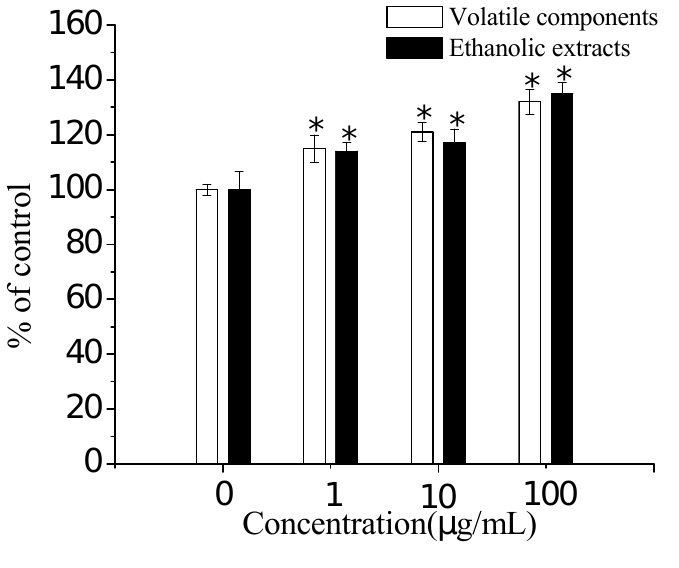
Figure 1. Effects of volatile components and ethanolic extract from E. prostrata on the proliferation of primary osteoblasts (n = 8, x ± SD; * p < 0.01, compared with